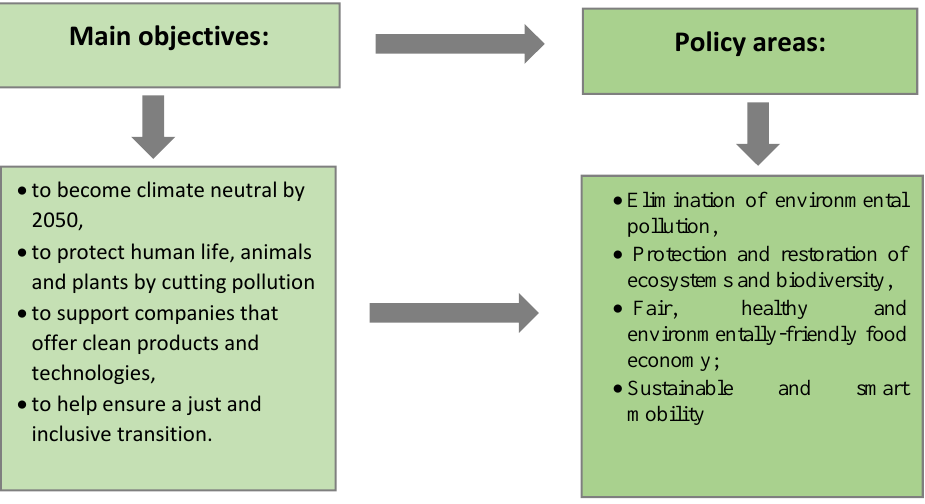
Figure 1. Main objectives of the European Green Deal. Source: own elaboration based on [26 – 28] The concepts of a “ green economy ” and “ green growth ” were shaped in a similar period, at the beginning of the second decade of the 21st century, but in different